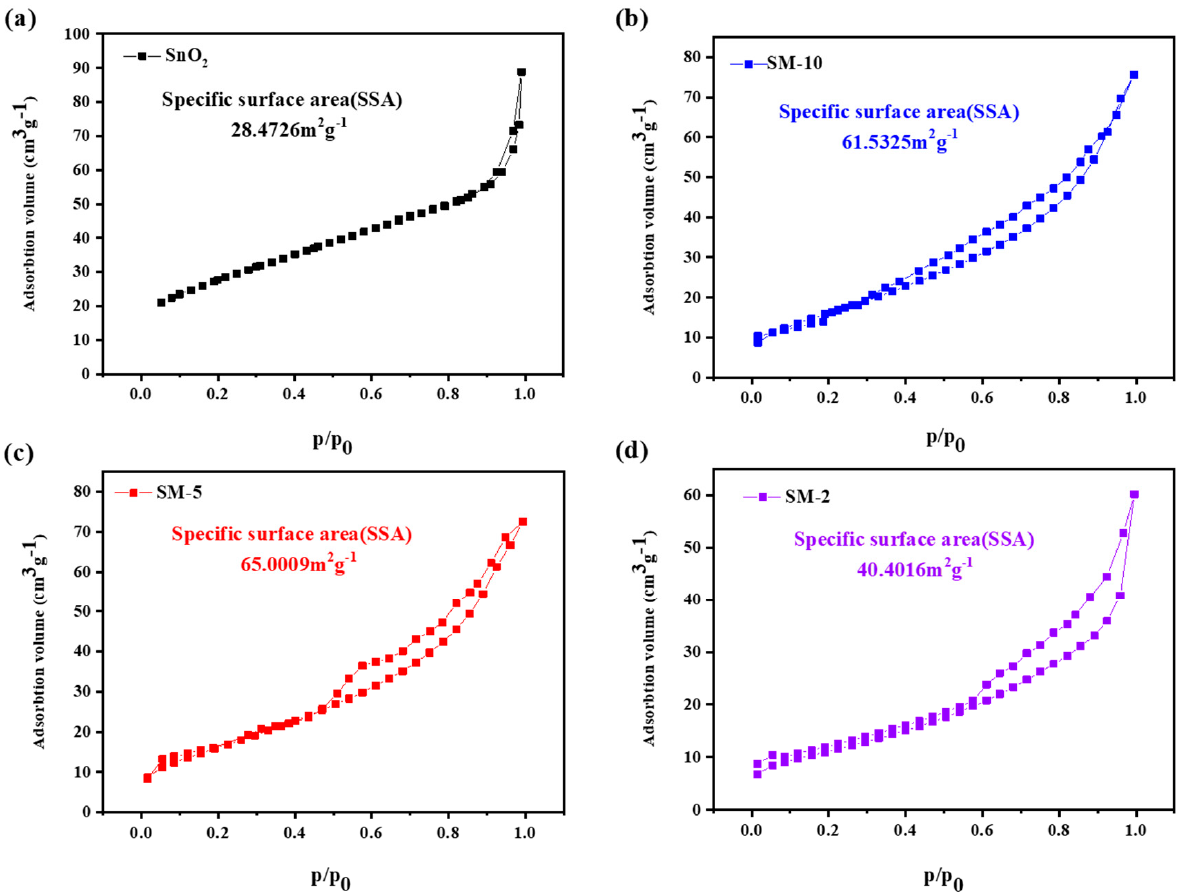
Figure 4. ( a – d ) Nitrogen adsorption desorption isotherms of SnO 2 , SM-10, SM-5 and SM-2.